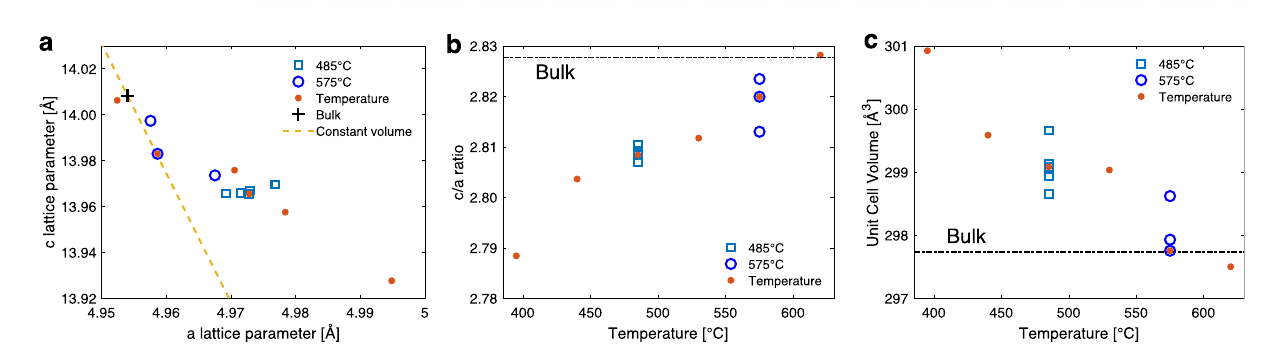
Figure 6. ( a ) X-ray diffraction scans and ( b ) resistance as a function of temperature for ∼ 60 nm thick V 2 O 3 films deposited at different power settings with fixed O 2 flow of 1.6 sccm and deposition temperature of 485 The dashed line in ( a ) shows the angular peak position of bulk V 2 O 3 30 . As the sputtering power is reduced the oxygen content of the V 2 O 3 becomes higher increasing the amount of oxygen interstitials in the film suppressing the MIT and shifting it to lower temperatures. The dashed line shows the resistance recorded for a sample grown with a lower oxygen flow setting of 1.4 sccm at a sputtering power of 150 W. Although the growth parameters are different the curve corresponds closely to the film grown at a lower O 2 flow setting and higher power. Results presented in ( b ) are reproduced with permission from samples and data presented in supplementary Fig. S6 from Ref. 11 .